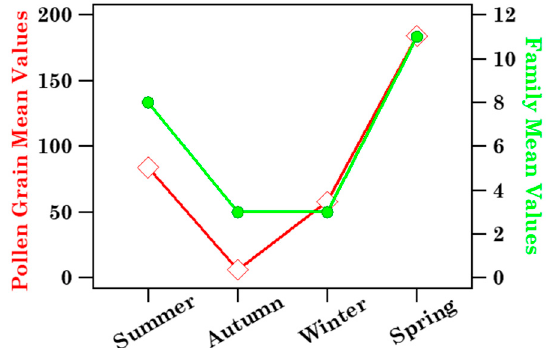
Figure 4. Mean values of the number of pollen grains and families monitored in Brindisi across the four seasons: summer (July, August, September), autumn (October, November, December), winter (January, February, March), and spring (April, May, June). Solid lines join the discrete data points to better visualize the respective seasonal trend. Seasons are listed according to the sampling date.